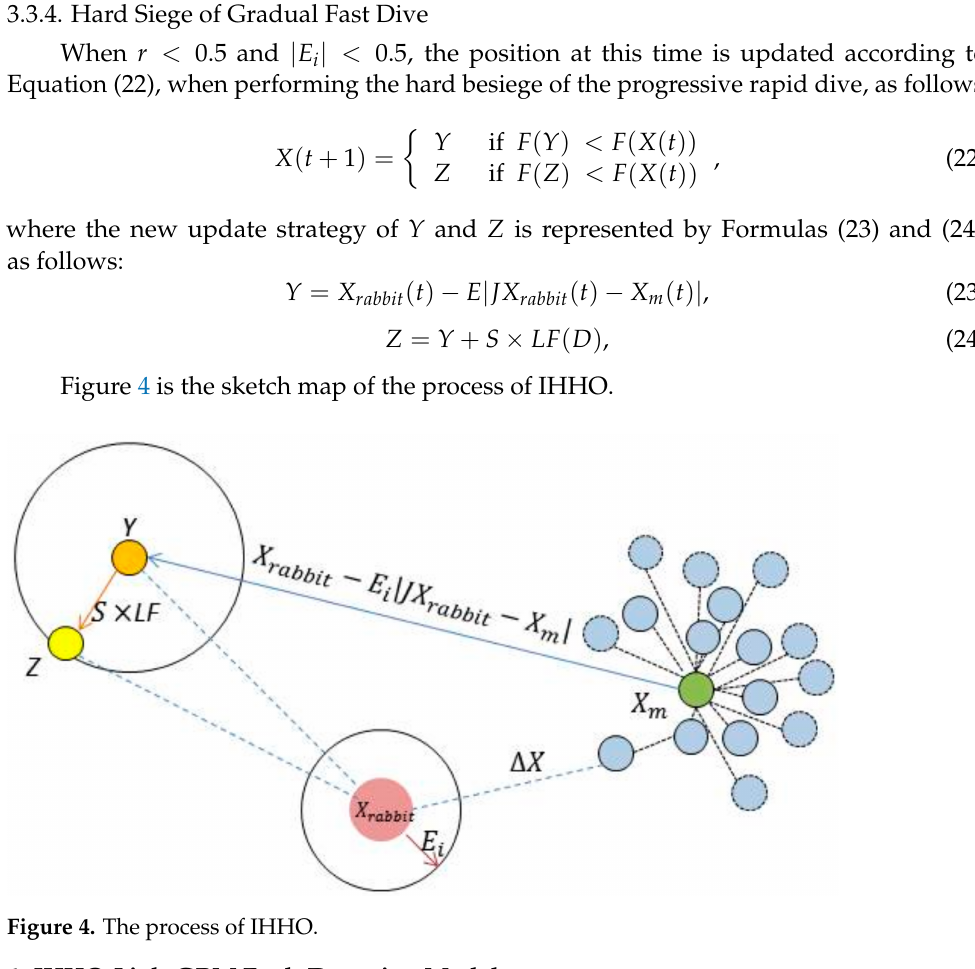
Figure 4. The process of